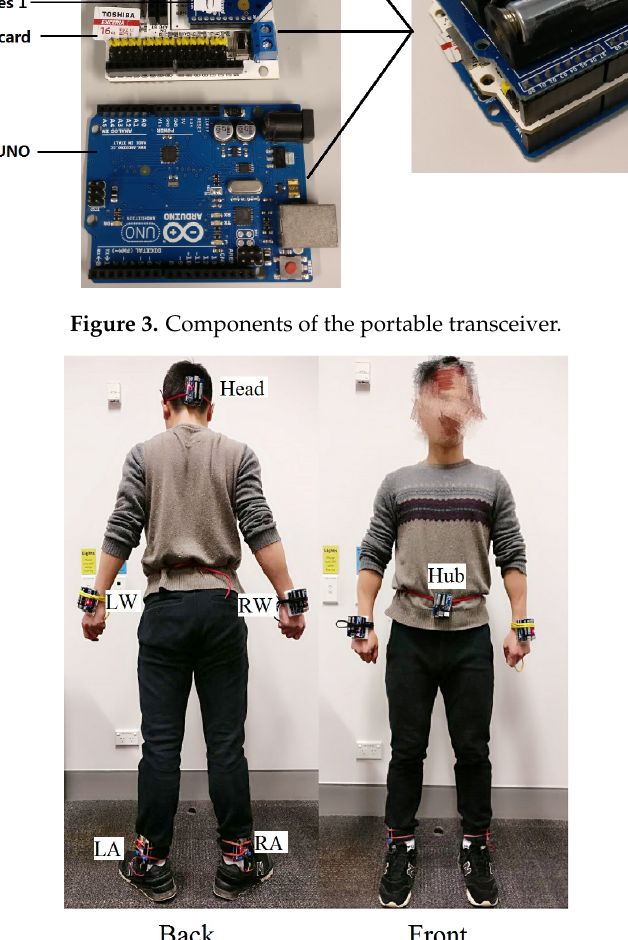
Figure 4. The measurement for direct